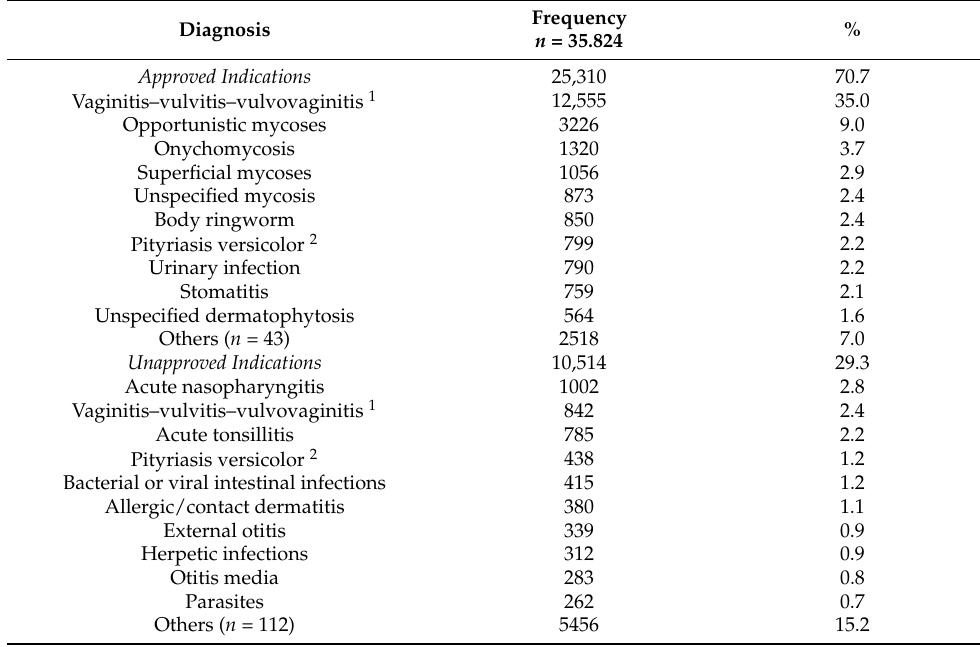
Table 2. Approved and non-approved indications related to the dispensing of systemic antifungals in a group of patients in Colombia,